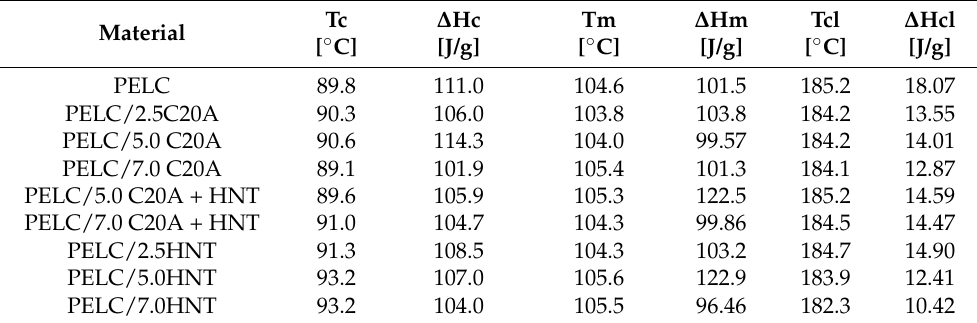
Table 2. Thermal properties of PELC based